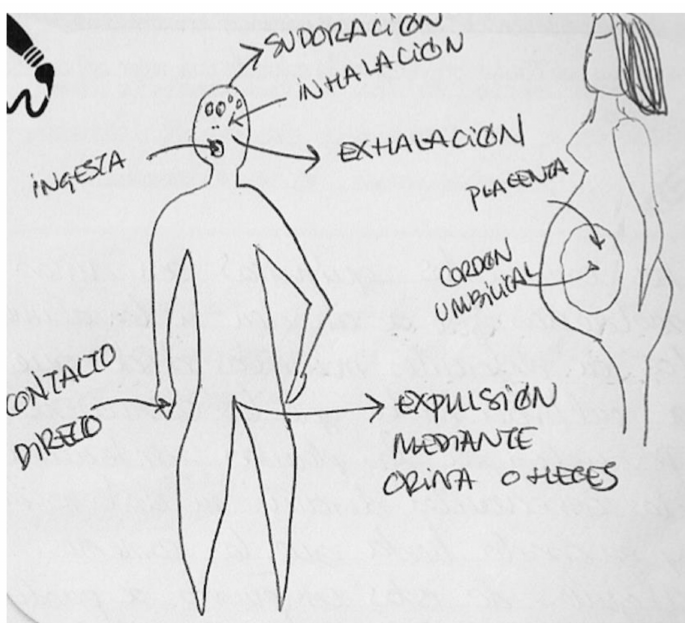
Figure 6. Pregnant, university education,